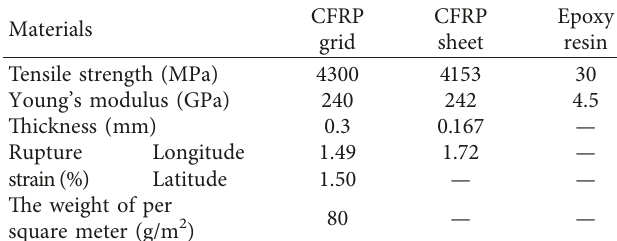
Figure 2: CFRP Table 1: Properties of CFRP grid, CFRP sheet, and epoxy resin from manufacturers.